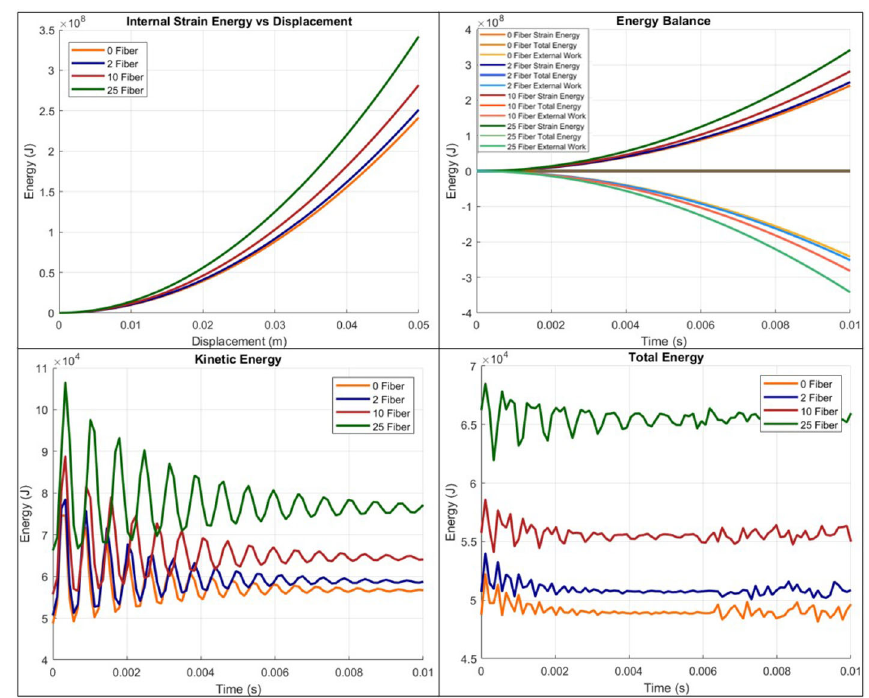
Fig. 7 Energy plots from the 0 fiber, 2 fiber, 10 fiber, and 25 fiber analyses with the applied displacement boundary condition. Although all of the models should be equivalent systems, adding embedded elements effects all types of